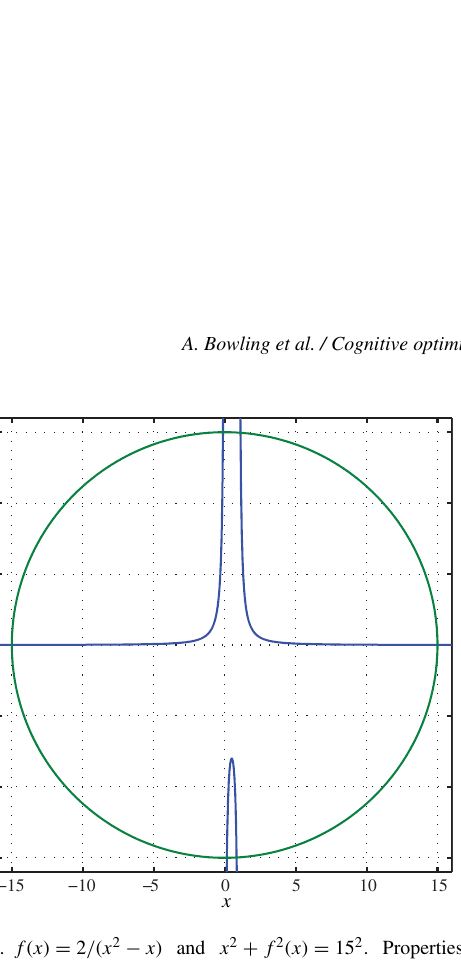
Fig. 16. f ( x ) = 2 / ( x 2 − x ) and x 2 + f 2 ( x ) = 15 2 . Properties: discontinuous, nonlinear, constrained, nonconvex, local optima,